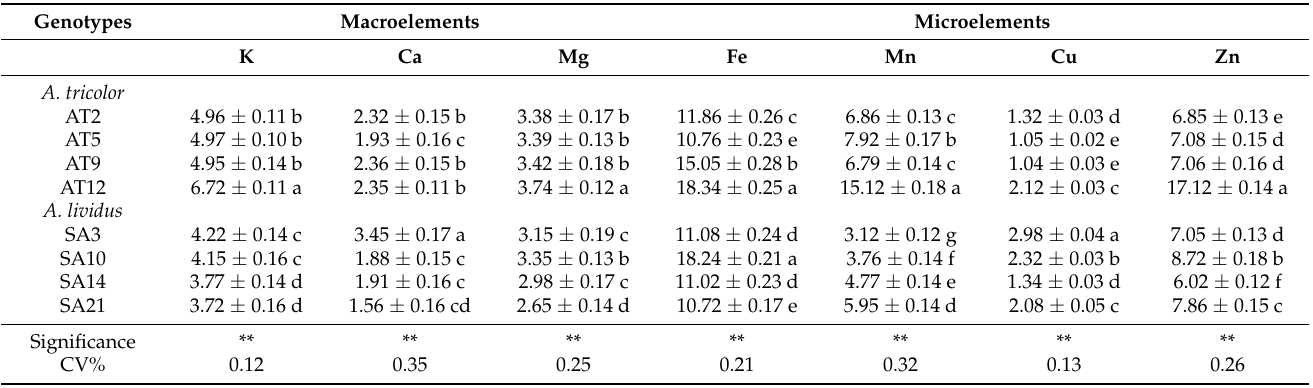
Table 2. Macroelements (mg g − 1 FW) and microelements ( µ g g − 1 FW) of two underutilized species of Amaranthus leafy